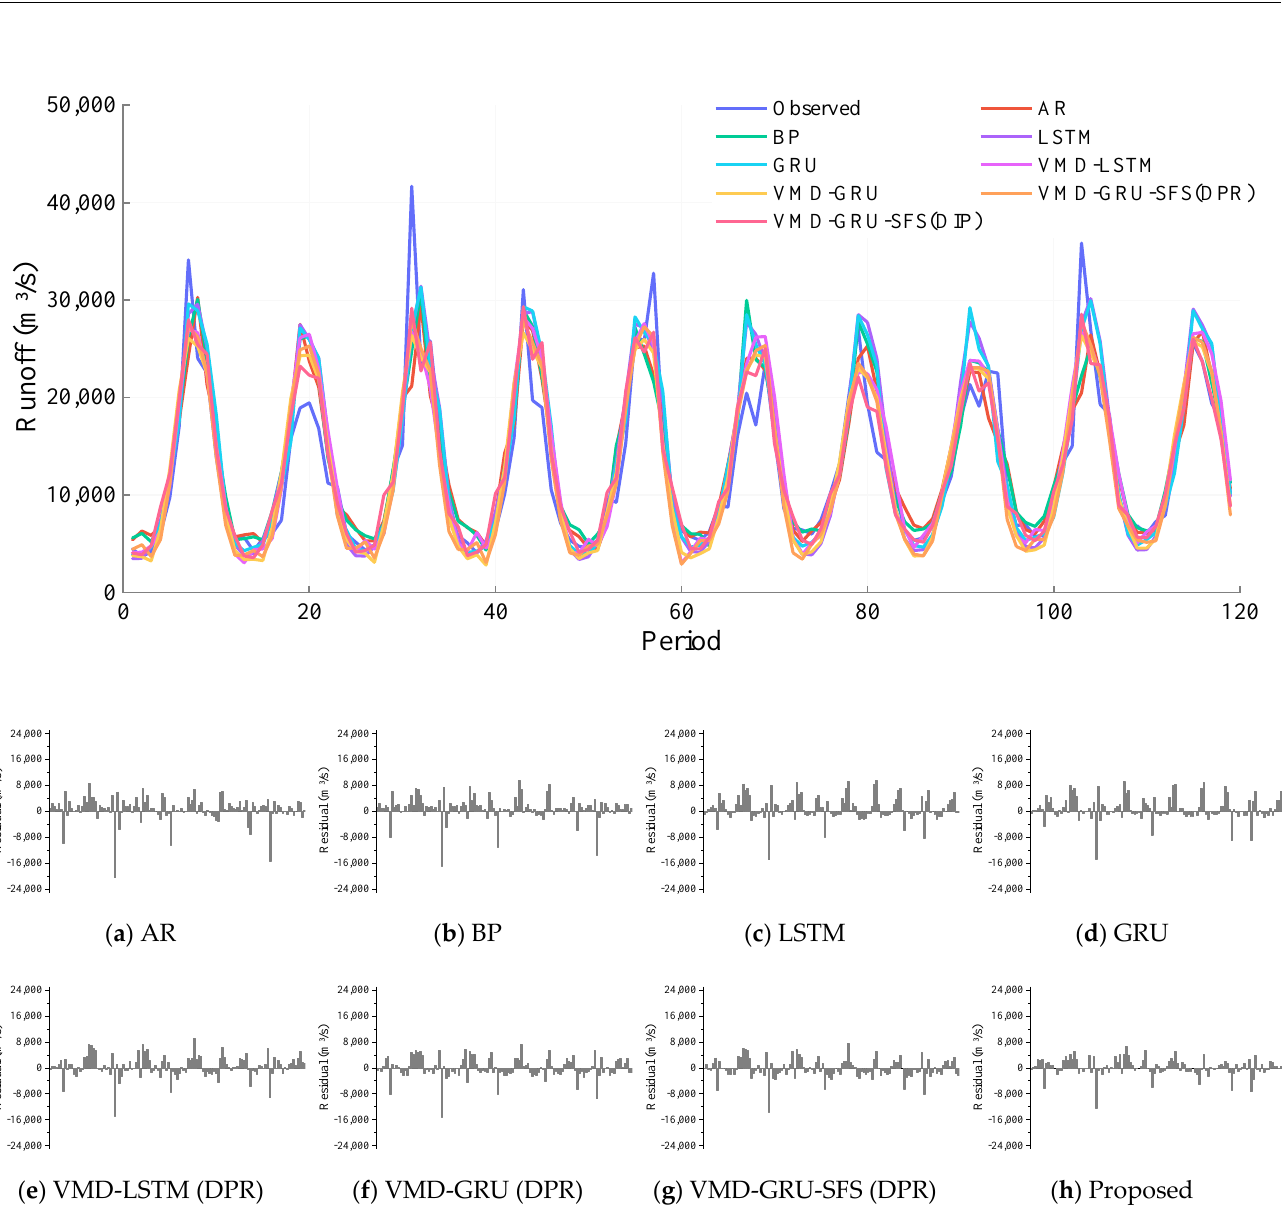
Figure 6. Prediction results and residual of different methods for the Yichang station. ( a ) AR model prediction residual; ( b ) BP model prediction residual; ( c ) LSTM model prediction residual; ( d ) GRU model prediction residual; ( e ) VMD-LSTM (DPR) model prediction residual; ( f ) VMD-GRU (DPR) model prediction residual; ( g ) VMD-GRU-SFS (DPR) model prediction residual; ( h ) Proposed model prediction residual.